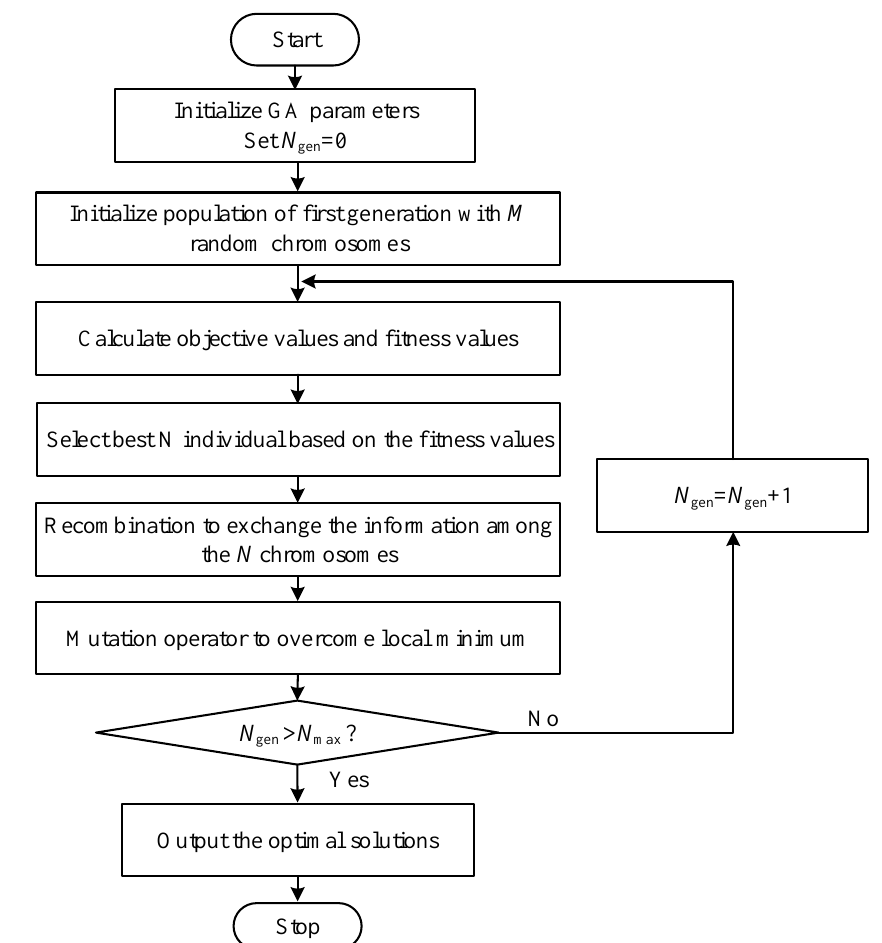
Figure 11. Flow chart of genetic algorithm